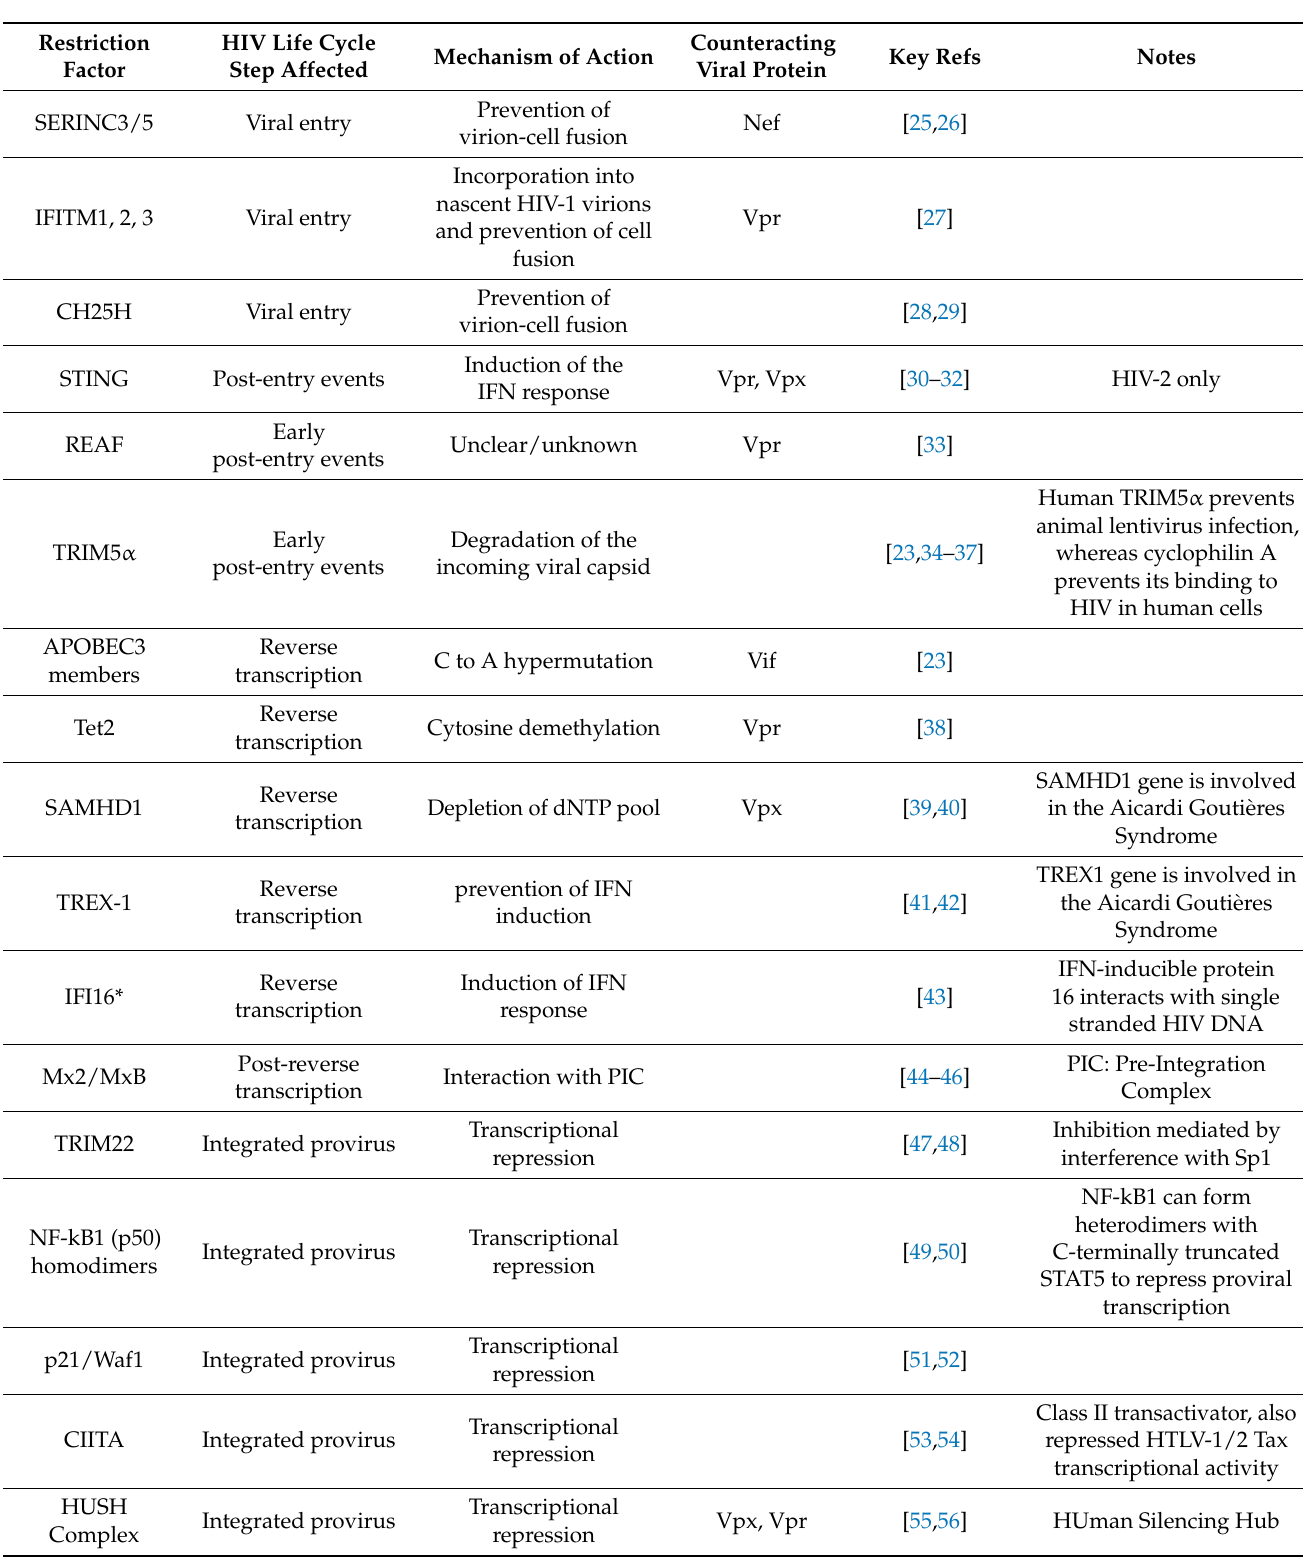
Table 2. Main restriction factors and other inhibitory molecules curtailing HIV infection or replication in human macrophages and T